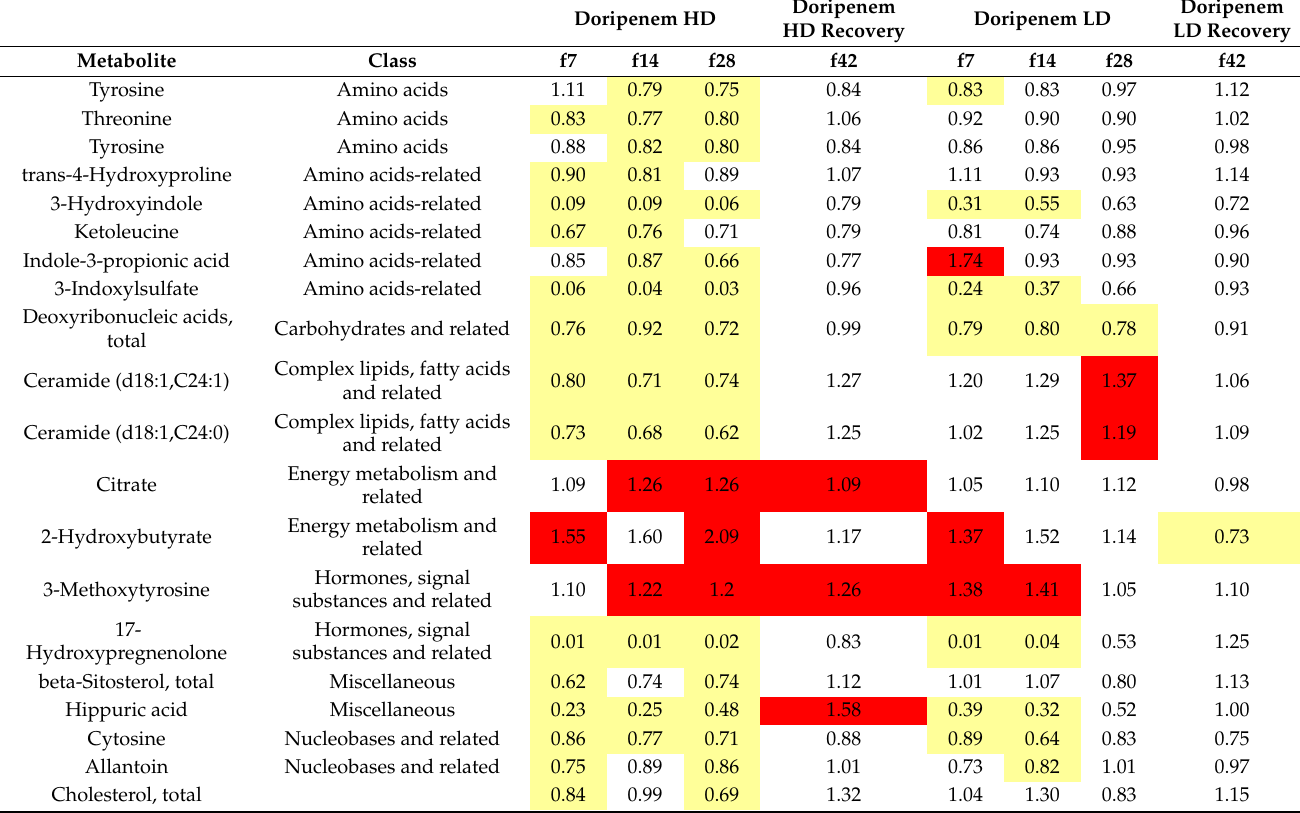
Table 10. Doripenem-induced plasma metabolite fold changes in female (f) Wistar rats (N = 5 per group) dosed with 100 (LD) and 1000 (HD) mg/kg bw/day observed on days 7, 14, and 28 (f7, f14, and f28) and on day 42 (f42) from the doripenem-recovery group. Statistically significant changes (Welch t -test; p -value < 0.05) are shown where red boxes mean a significant increase, yellow boxes mean a significant decrease, and white boxes indicate an insignificant change in the respective plasma metabolites compared to control